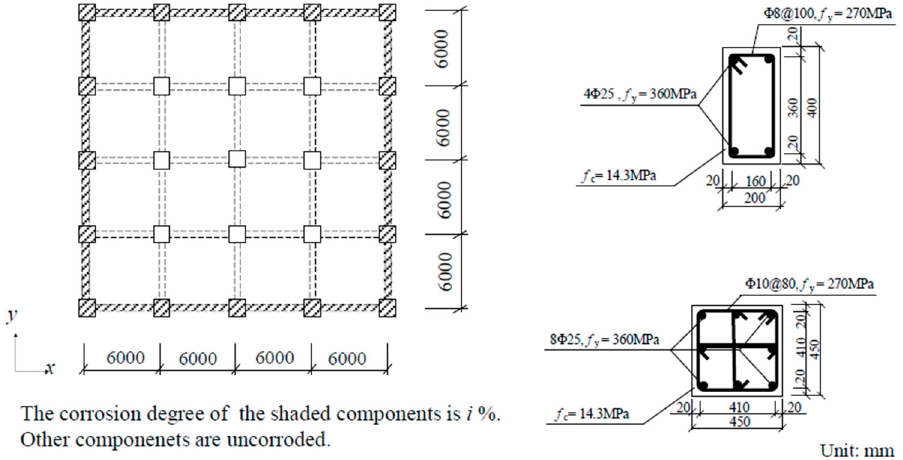
Figure 8. Design details of the RC frame structure. Table 2. Parameters of simulation cases.